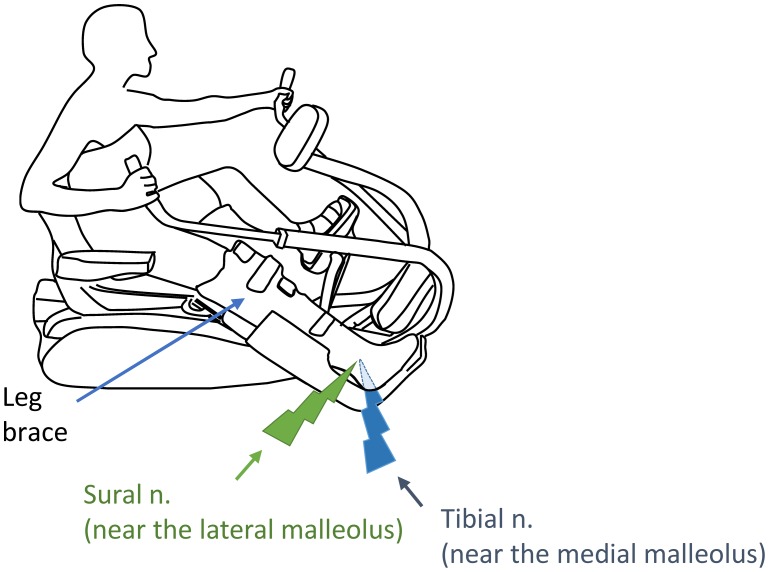
Experimental set-up for arm and leg remote rhythmic movement (ARM&LEG) on the recumbent stepping ergometer with assisted the arms.Nerve stimulation on the right leg was delivered at the start of the recovery phase of the left leg. Green lightning bolt: sural nerve stimulation (near the lateral malleus). Blue lightning bolt: distal tibial nerve stimulation (near the medial malleus).